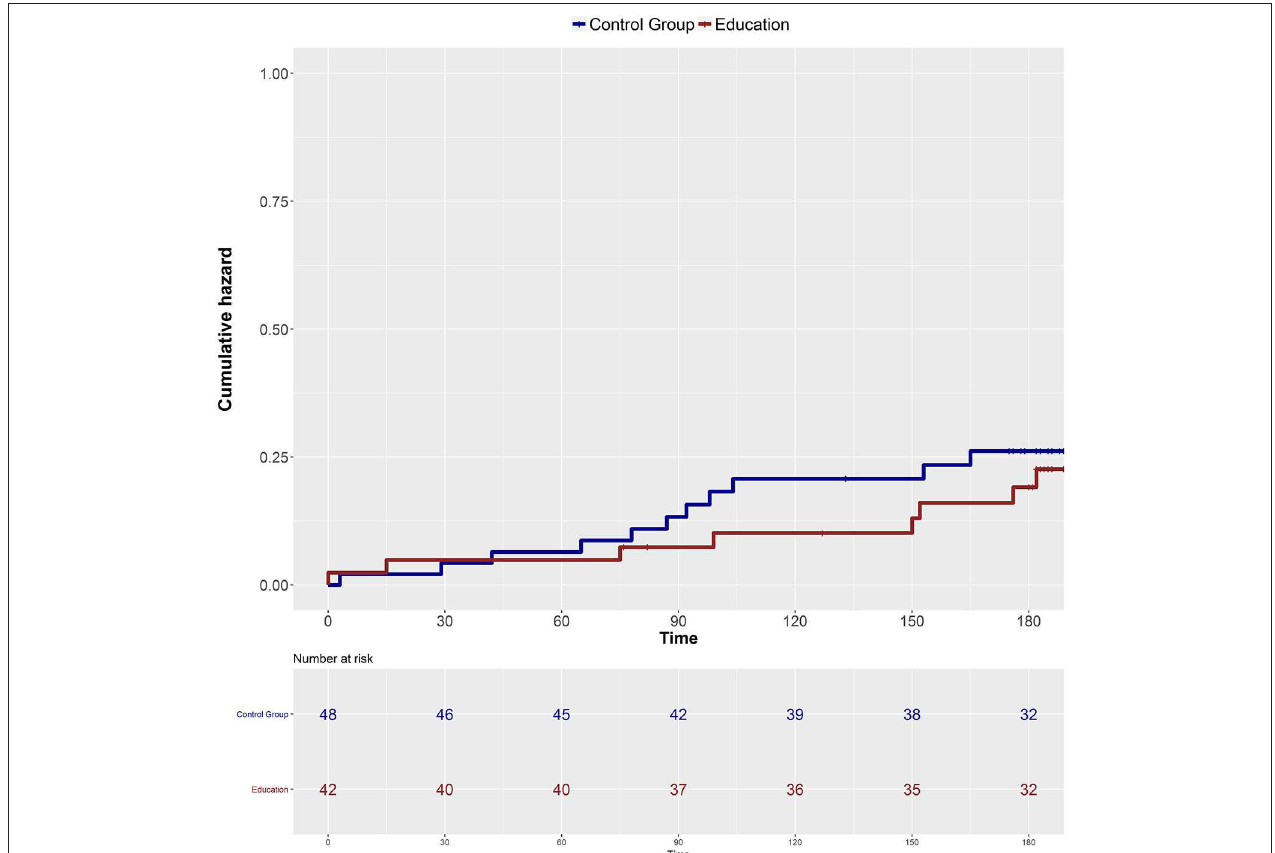
FIGURE 2 | Cumulative hazard of falling over time in the two groups.